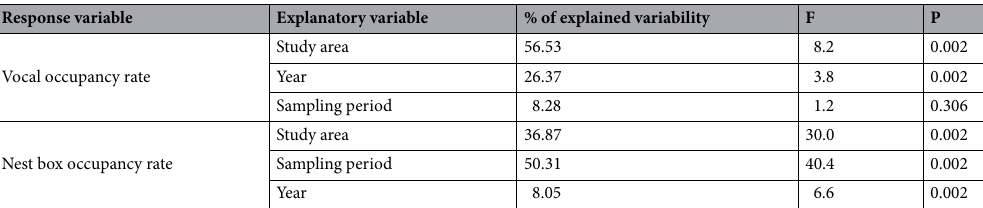
Table 3. The results of CCA analyses. First analysis: the effect of the study area (Ore Mts., Trebon Basin), year (2015–2017), and sampling period (April, May) on the vocal occurrence (0/1) of each owl species. Second analysis: the effect of the study area, year, and sampling period (spring, autumn) on nest box occupancy (0/1) by animal taxa (boreal owl, goldeneye, pine marten, passerines, bats, and